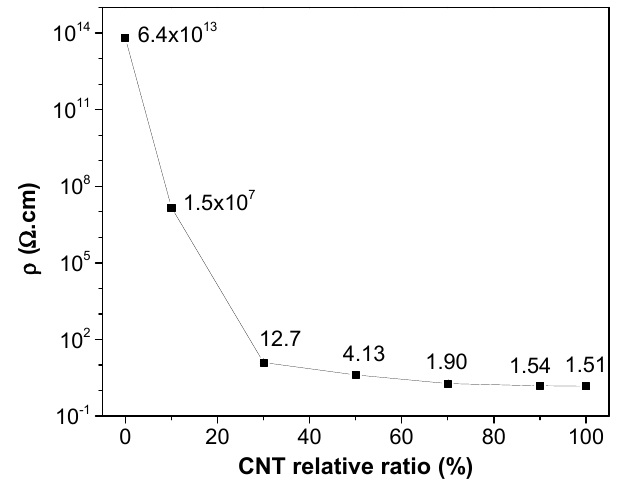
Figure 6. Electrical volume resistivity of 6 wt.% GNP/CNT nanocomposites at different CNT contents produced by compression molding.